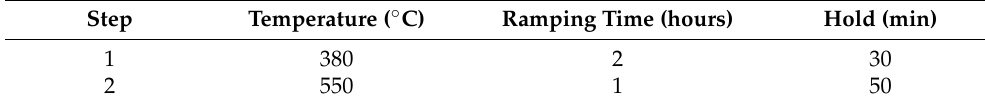
Table 2. Microwave assisted ashing